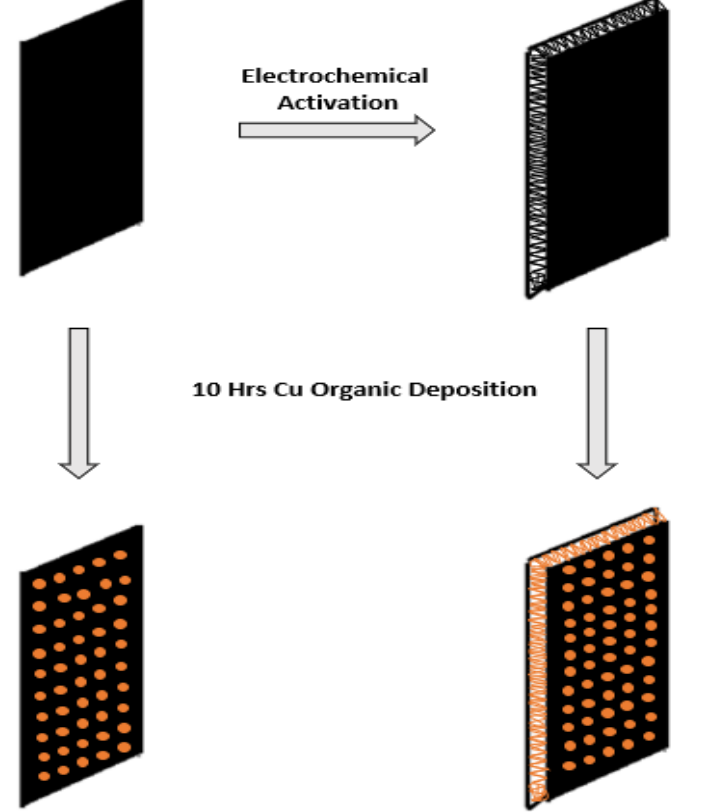
Figure 1. The illustration of process steps used for preparing CNT samples for analysis.